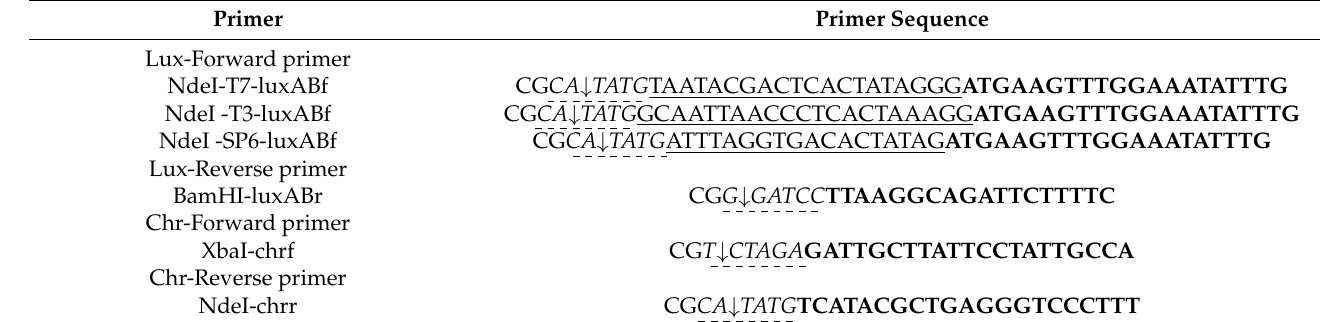
Table 1. Sequence of the primers used in this